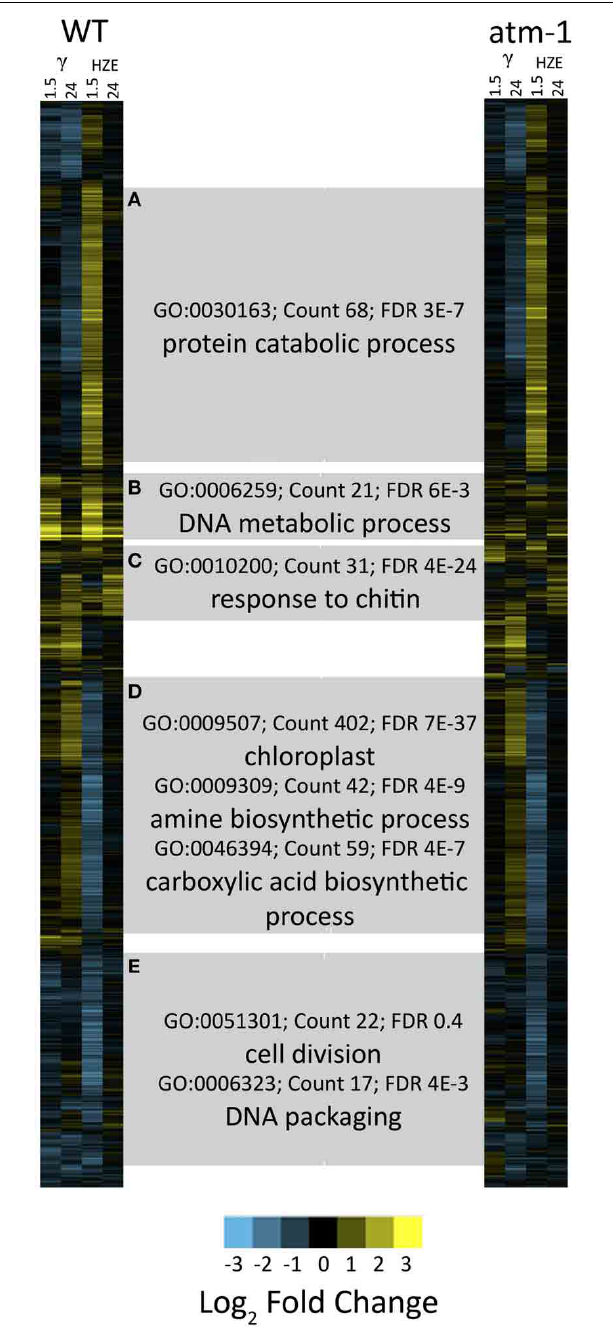
FIGURE 1 | Clustered expression patterns display coordinated responses to gamma and HZE radiation. For the set of all transcripts moderately induced/repressed at 1.5 or 24h after IR treatment (fold change > 2 or < − 2 and adjusted p -value < 0.05 in response to HZE or gamma radiation, for WT or atm-1 plants), we display clustered expression profiles. Each column indicates a particular experimental condition (combination of stress, time point, and spatial region). The profiles are clustered (row clustering) only in terms of the expression values at 1.5 or 24h after IR treatment. Horizontal gray bars indicate the selection of transcripts in each cluster (A–E) . Labels represent significant enrichment for selected GO terms (see